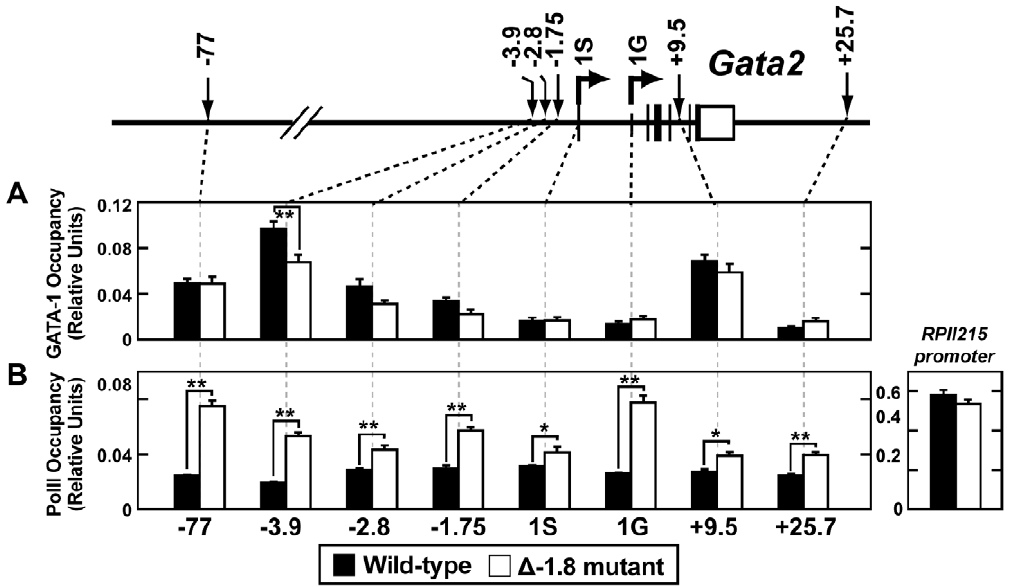
Figure 6. Loss of the 2 1.8 kb site leads to increased RNA Pol II occupancy of the Gata2 locus. Quantitative ChIP analysis across the Gata2 locus using antibodies to GATA-1 (A) and RNA Pol II (B) in whole fetal liver cells from wild-type and D -1.8 embryos at E14.5. Calculations were derived using percentage of input and were normalized using relative units which were determined by defining 9% input sample as 1.0.